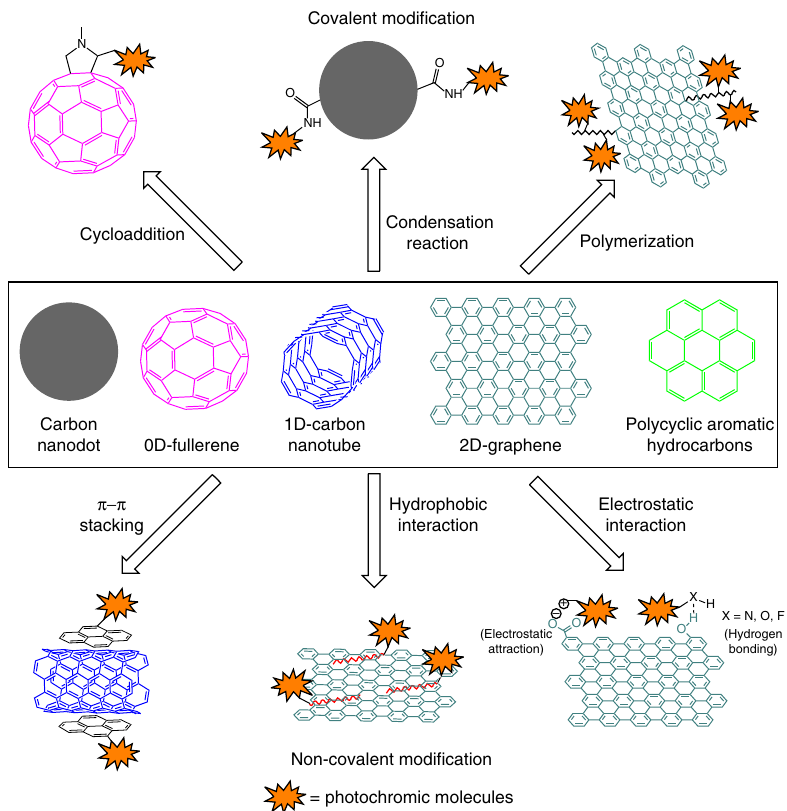
Figure 2 | Functionalization of carbon-based nanomaterials with photochromic molecules. The functionalization can be performed through either covalent or non-covalent approaches. Non-covalent modification includes p – p stacking, hydrophobic interaction or electrostatic interaction, which only mildly perturbs the sp 2 structure of the carbon allotrope. While covalent functionalization can be done via cycloaddtion, condensation reaction or radical polymerization and so on, offering strong and robust bonding. 0D, zero dimensional; 1D, one dimensional; 2D, two